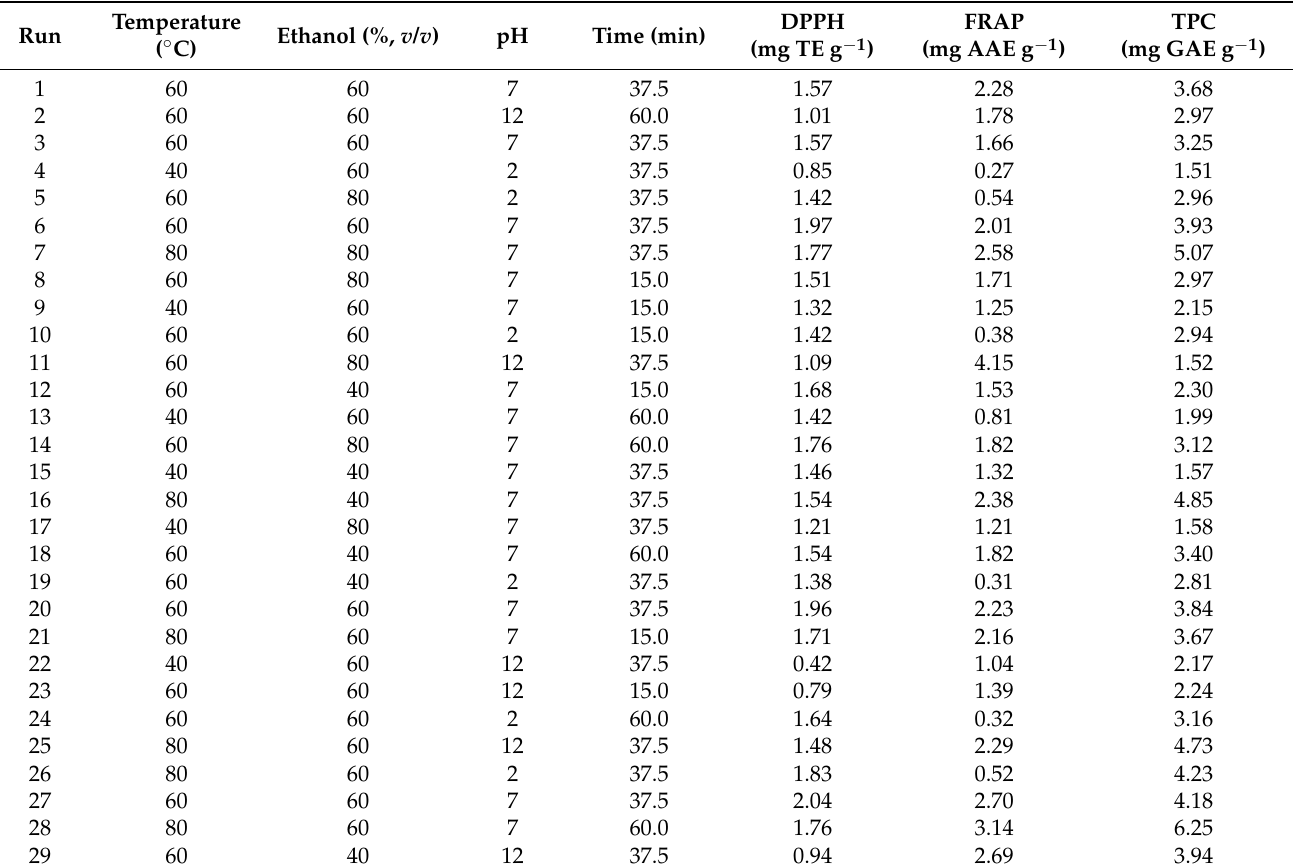
Table 1. Box–Behnken experimental design matrix and DPPH, FRAP, and TPC results, expressed on a dry-weight (DW) basis, for ASE by